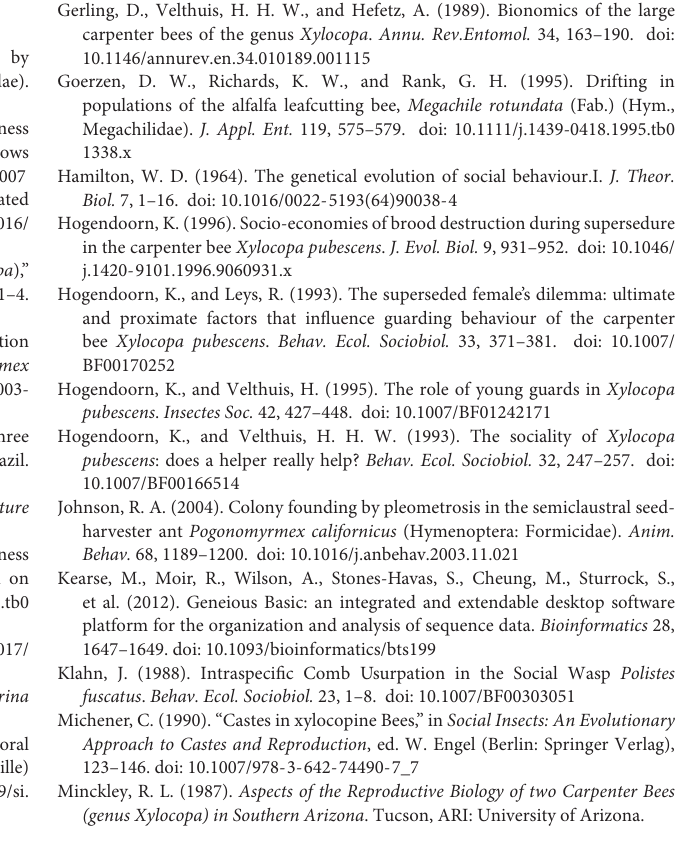
associated DF and